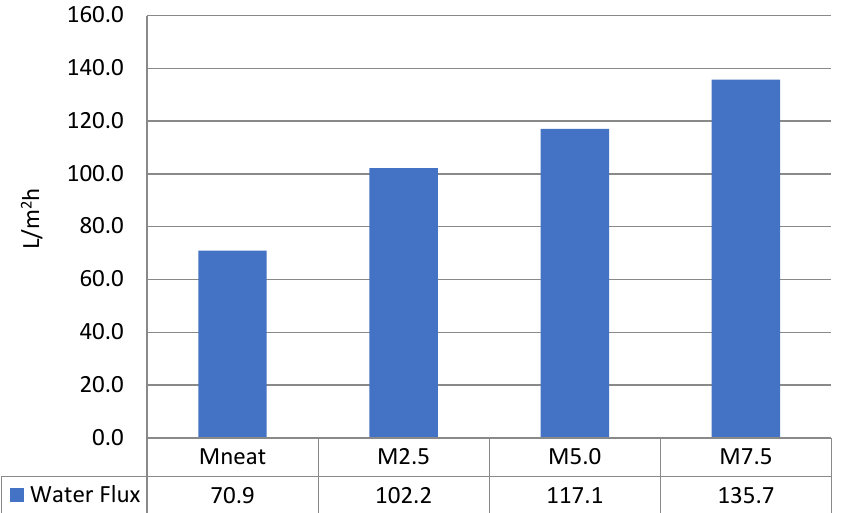
Figure 7. Pure water flux of M2.5, M5.0, and M7.5 AHFM in comparison with MNeat membrane ( n = 3).